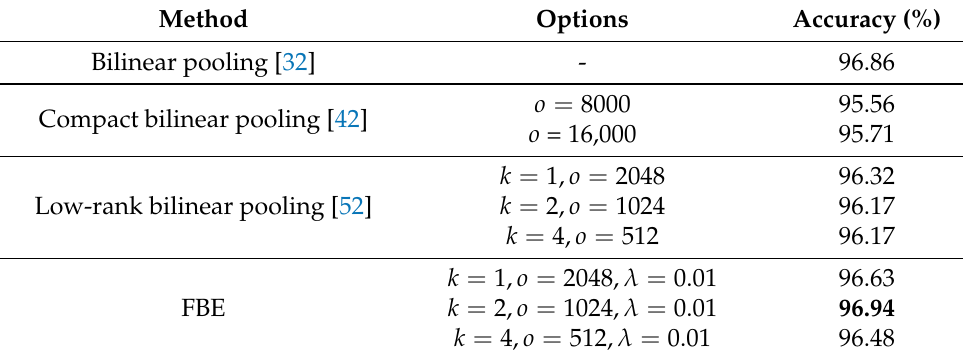
Table 5. Overall accuracies of different fusion methods on dataset